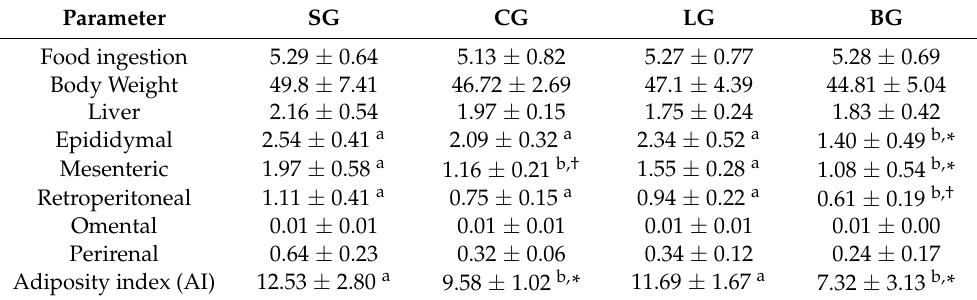
Table 1. Food ingestion, body final weight, weight of liver, and visceral fats in grams (g) based on the dissection and adiposity index for animals treated for 60 days with diets containing different vegetable